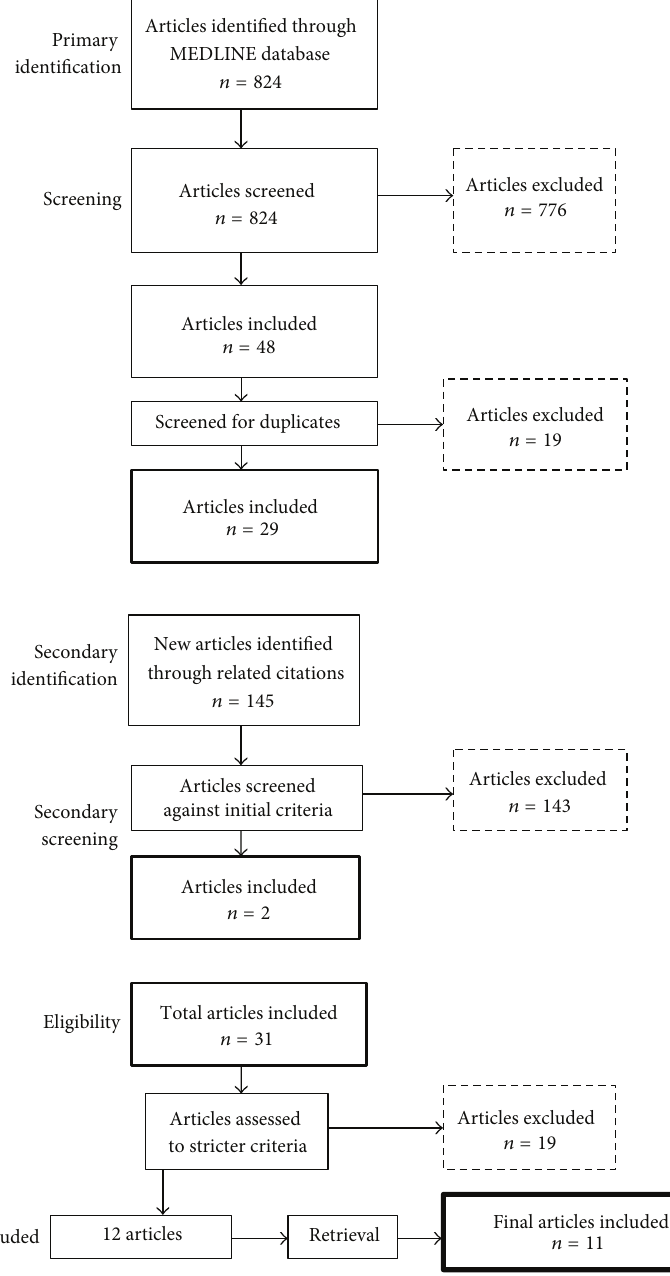
Figure 1: Flow chart showing the method of identifying eligible articles for the purpose of our